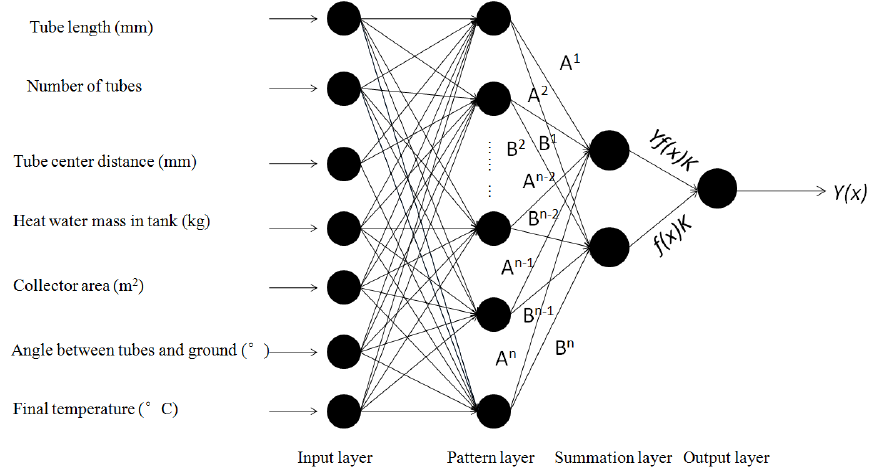
Figure 4. Structure of the general regression neural network (GRNN).